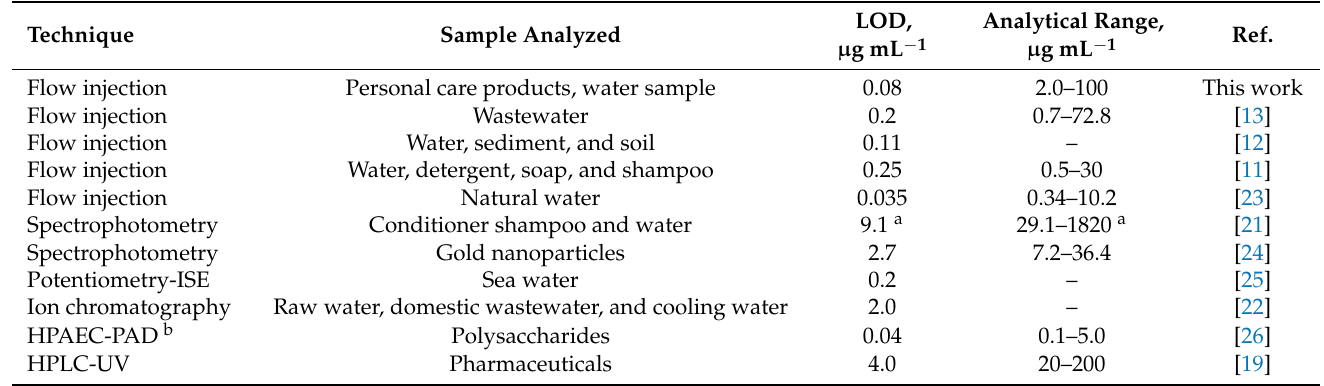
Table 9. Comparison of the developed flow injection Cu-PCV procedure to other reported methods for the determination of